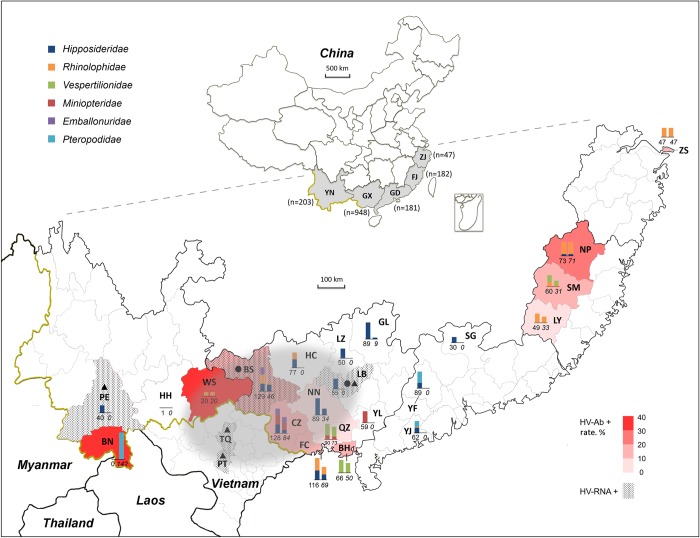
Information of sample collection and detection.Bat sera and/or tissues were collected from 22 cities in 4 provinces: Xishuangbanna (BN), Honghe (HH), Pu’er (PE) and Wenshan (WS) cities in Yunnan (YN) Province; Beihai (BH), Baise (BS), Chongzuo (CZ), Fangchenggang (FC), Guilin (GL), Hechi (HC), Laibin (LB), Liuzhou (LZ), Nanning (NN), Qinzhou (QZ) and Yulin (YL) cities in Guangxi (GX) Zhuang Autonomous Region; Shaoguan (SG), Yunfu (YF) and Yangjiang (YJ) cities in Guangdong (GD) Province; Nanping (NP), Longyan (LY) and Sanming (SM) cities in Fujian (FJ) Province; and Zhoushan (ZS) city in Zhejiang (ZJ) Province. The combined 2 bars represent numbers of bat samples collected in each city, either tissues (left) and serum (right). Total samples are listed under each bar. Lengths of color boxes in the bars represent the numbers of sampled bats at family level (color illustration is on upper left). The number of sampled bats in each province is shown on the upper Chinese map. Hantavirus seropositive rates (HV-Ab+ rate) in different cities are indicated by different shades of red. Bar scale of red color density on the lower right represents the rates from 0% to 40%. Filled circles and triangles indicated where LAIV and XSV were identified. The shaded grey oval region is the proposed main circulation sphere of bat-borne HVs.